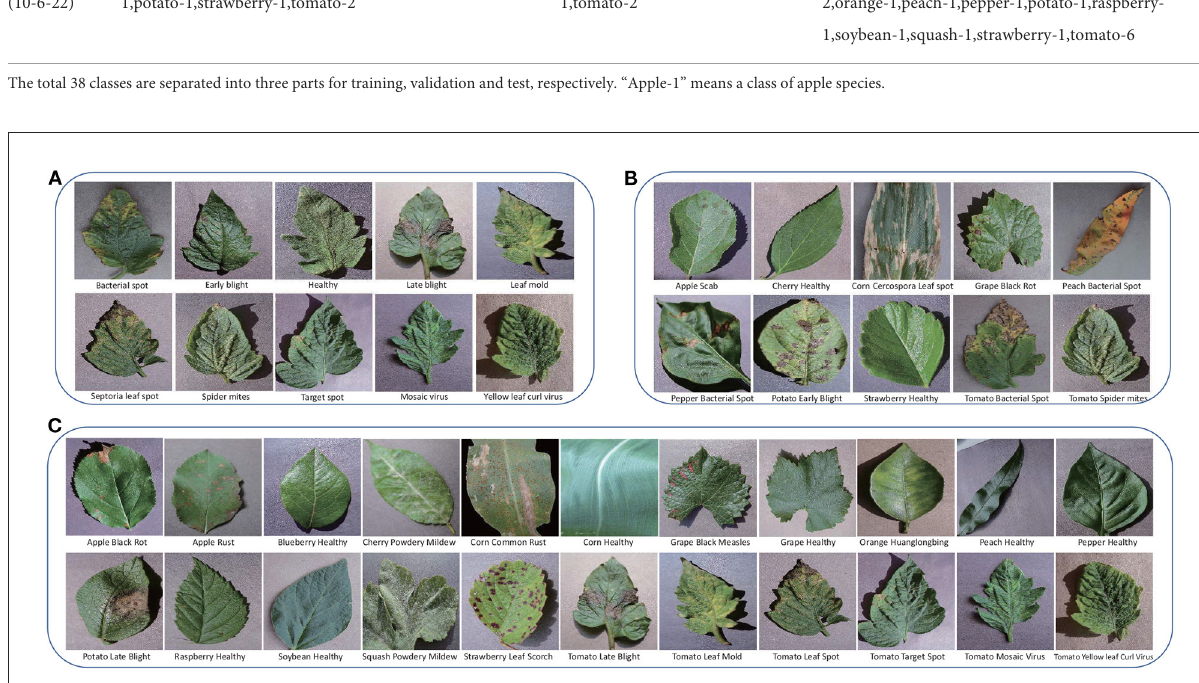
FIGURE3 (A) The testing classes of PV-Setting-1. (B) The testing classes of PV-Setting-2. (C) The testing classes of